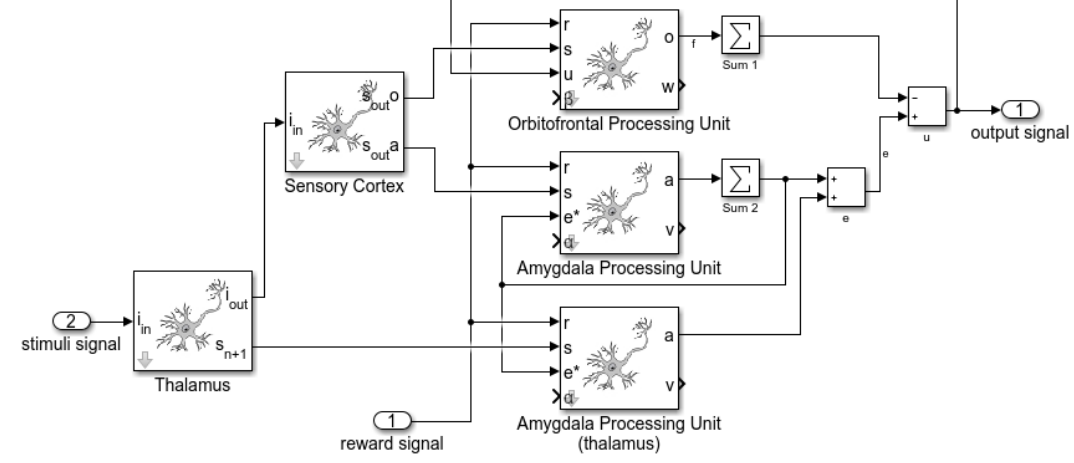
Figure 3. Brain emotional learning model block